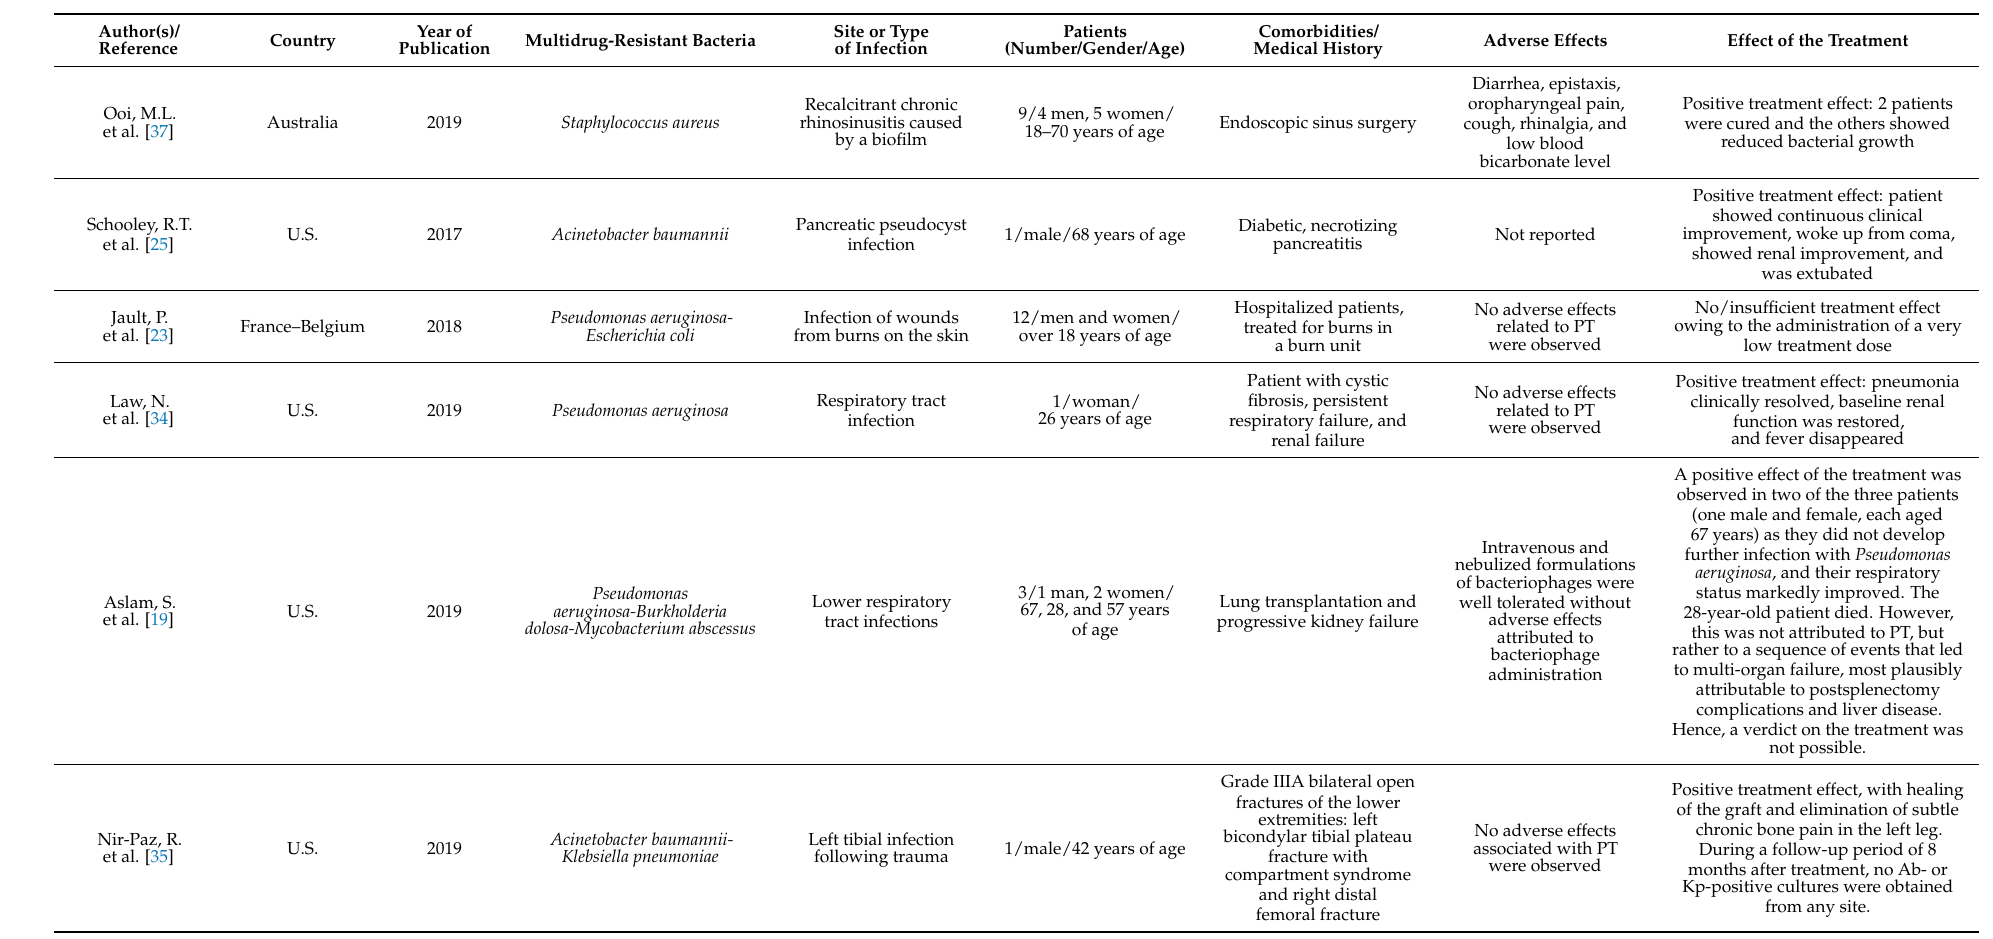
Table 1. Data collection, after reading the full texts of the selected